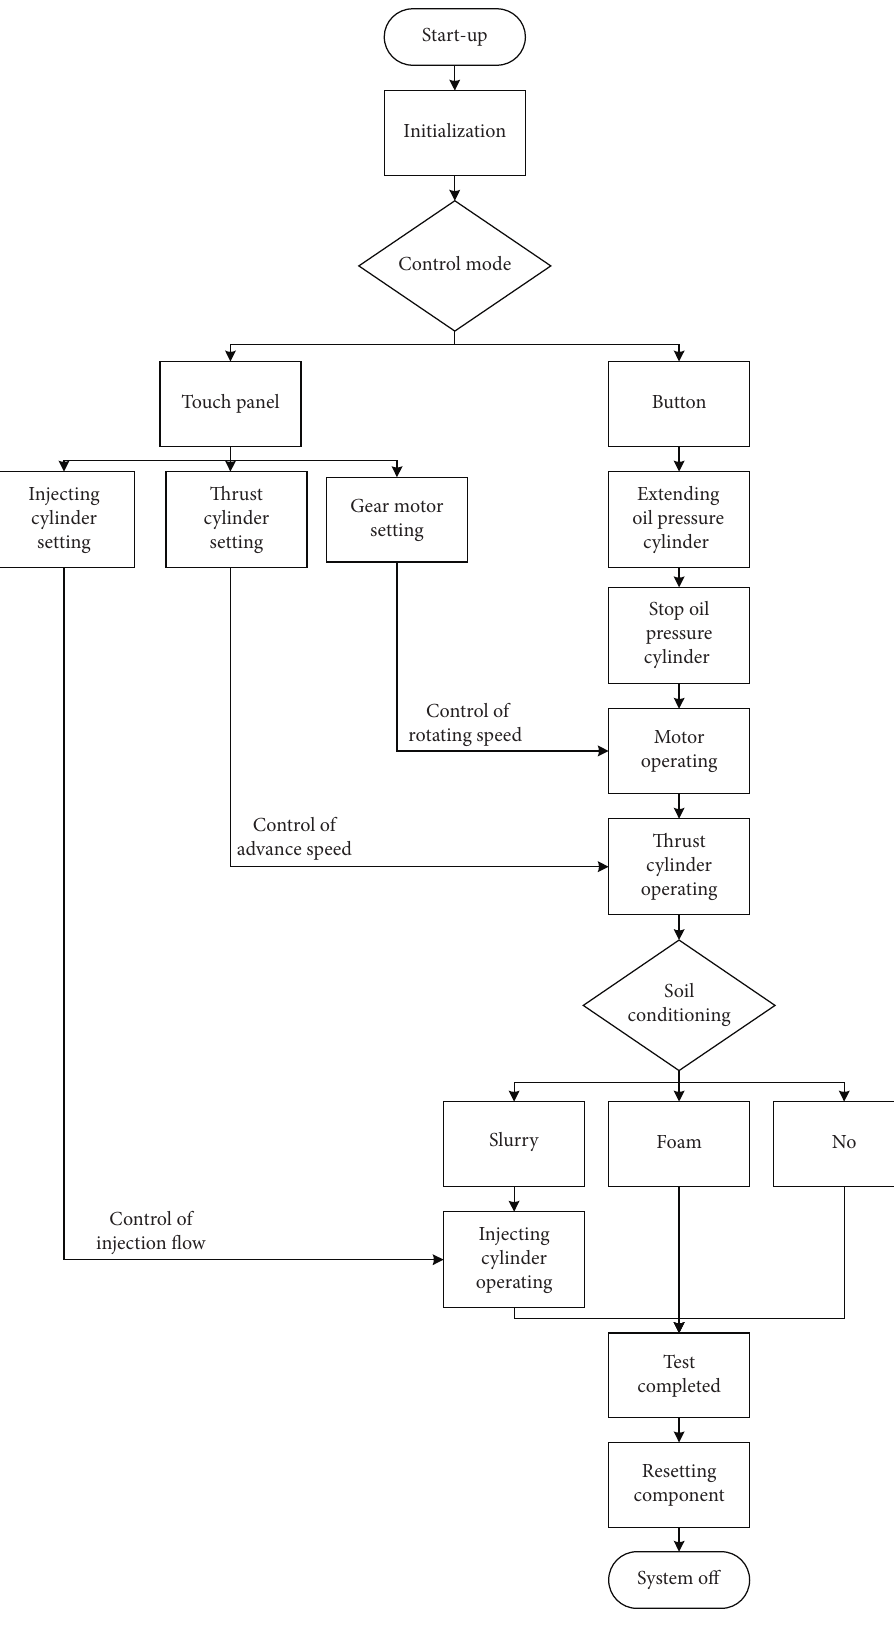
Figure 18: The testing